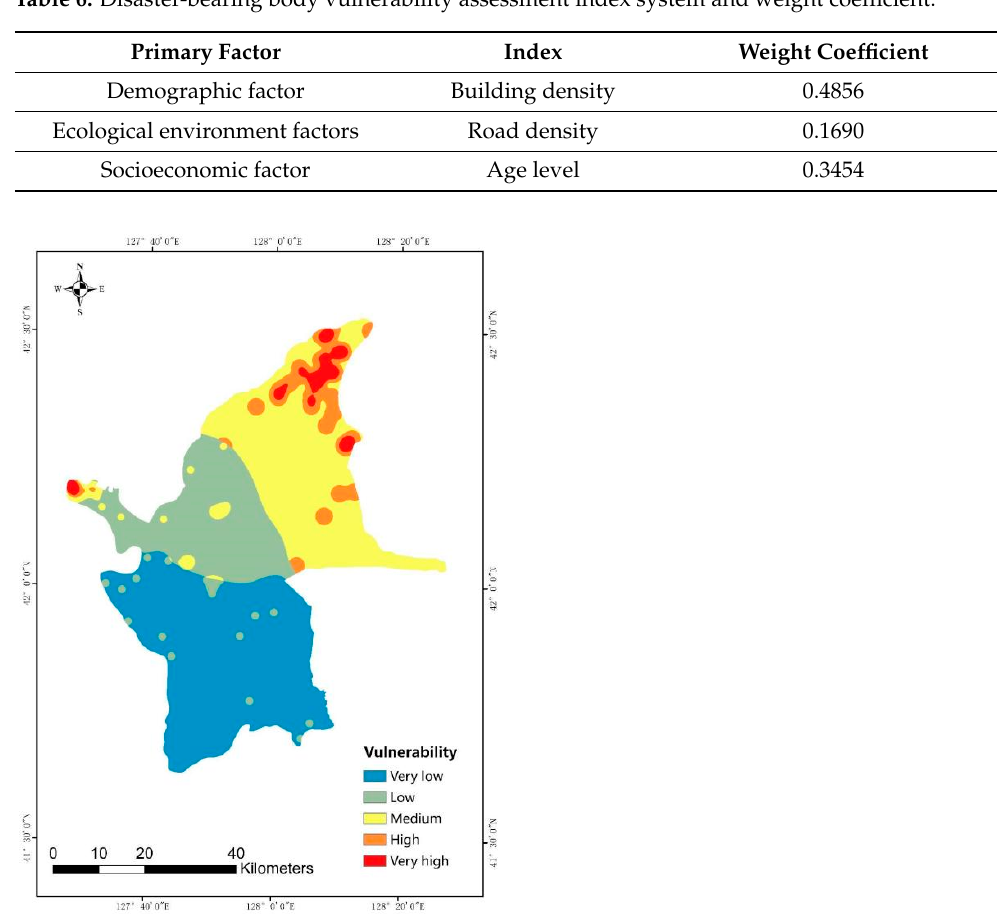
Figure 10. Earthquake landslide disaster risk maps.